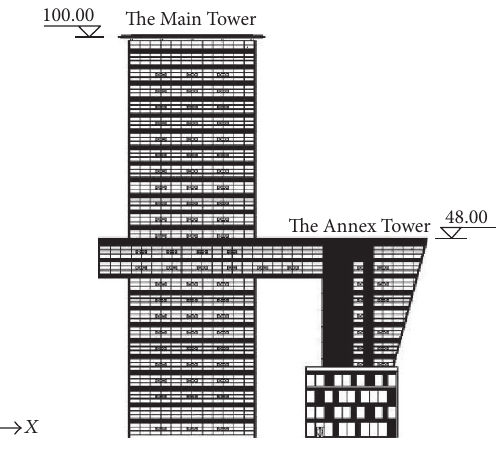
Figure 3: Structural